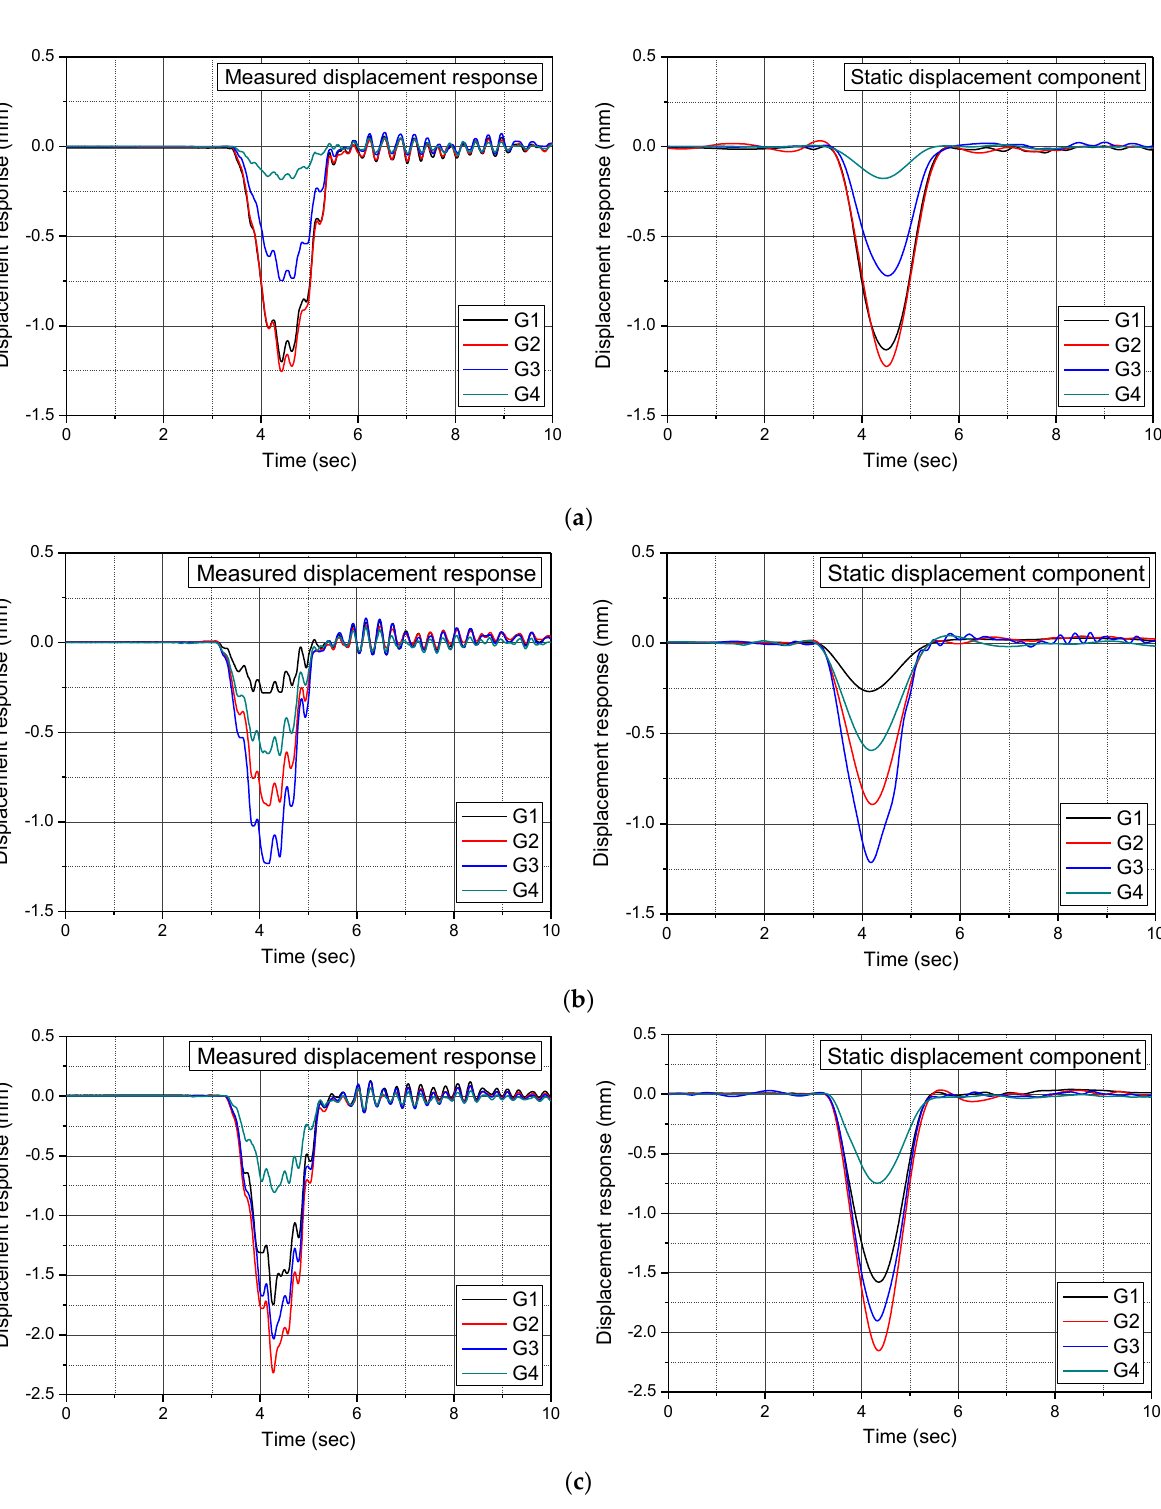
Figure 7. Measured displacement response and static displacement component in LCs with a vehicle velocity of 60 km/h: ( a ) LC 3; ( b ) LC 7; ( c ) LC 11.